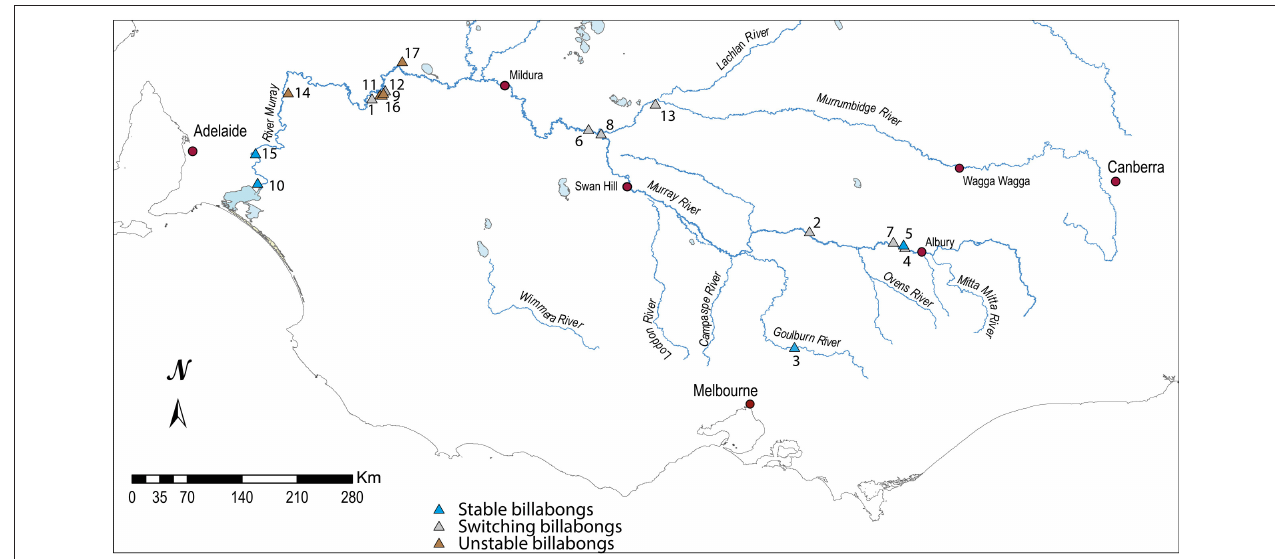
FIGURE 3 | Distribution of the 17 billabongs in the southern Murray Darling Basin classed by response type.